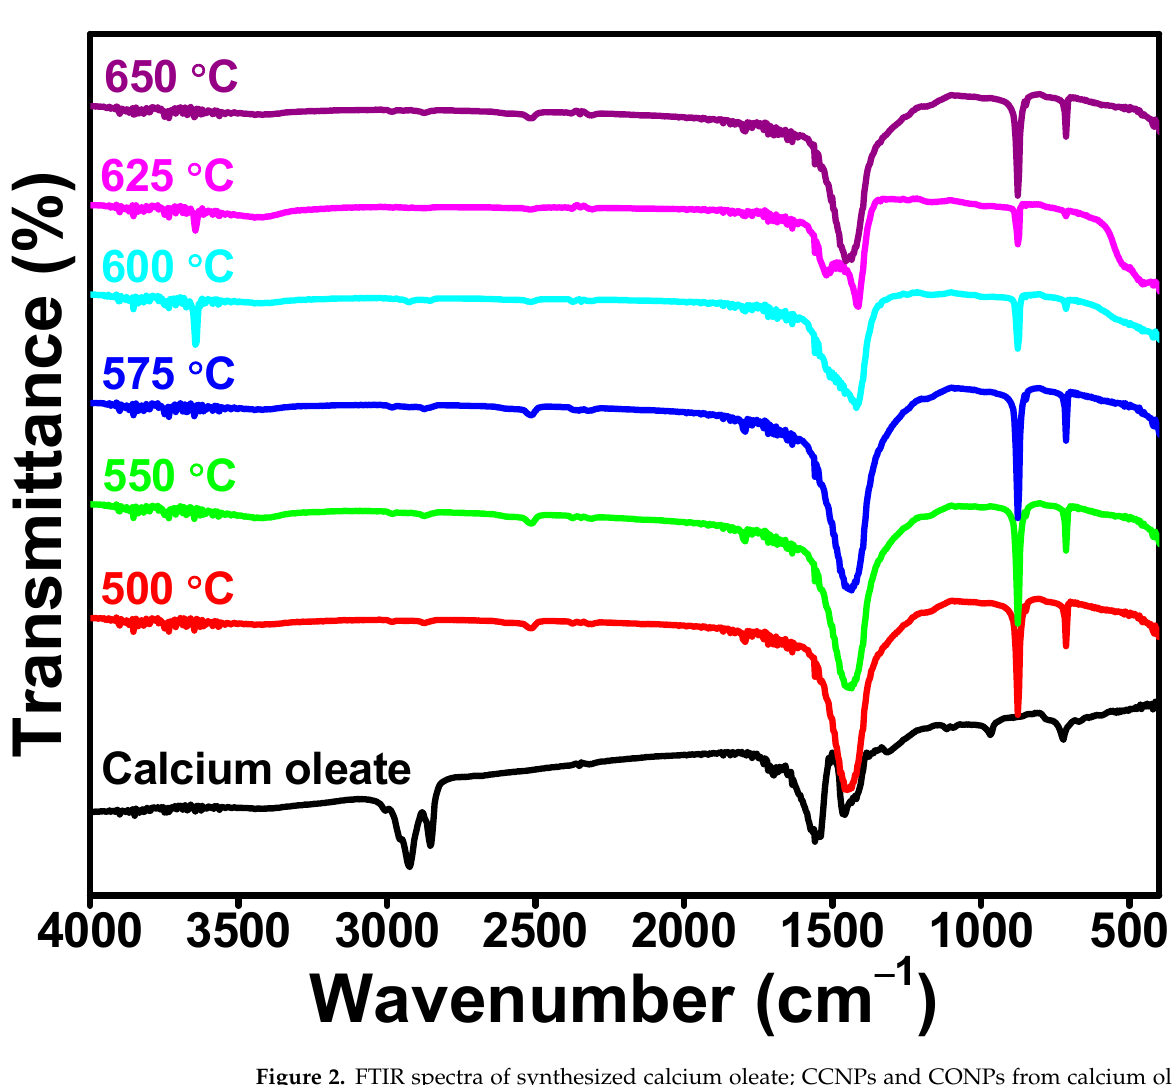
Figure 2. FTIR spectra of synthesized calcium oleate; CCNPs and CONPs from calcium oleate at different carbonization/calcination temperatures.